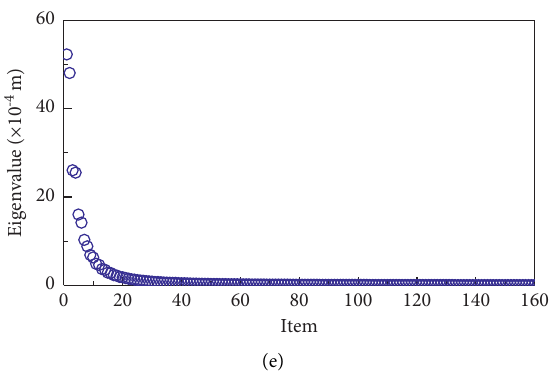
Figure 3: Eigenvalues of each grade of road roughness: (a) class A: very good; (b) class B: good; (c) class C: average; (d) class D: poor; (e) class E: very poor.